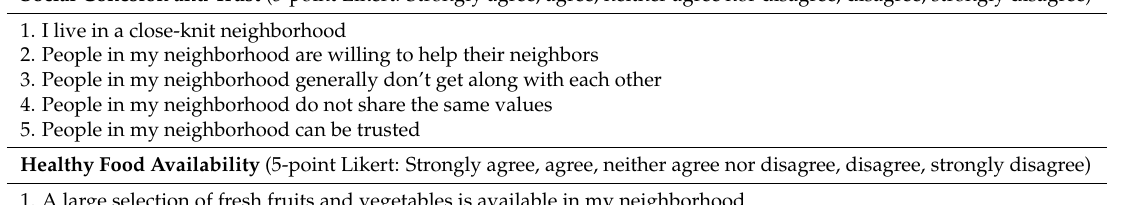
Table 1. Subjective measures of the physical and social residential environment; Life Influences on Fetal Environments Study